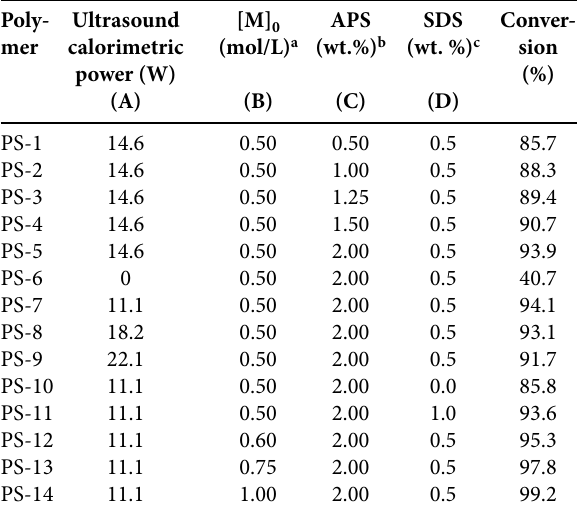
Table 1. Polymerization conditions and the final monomer conver- sions. Poly-